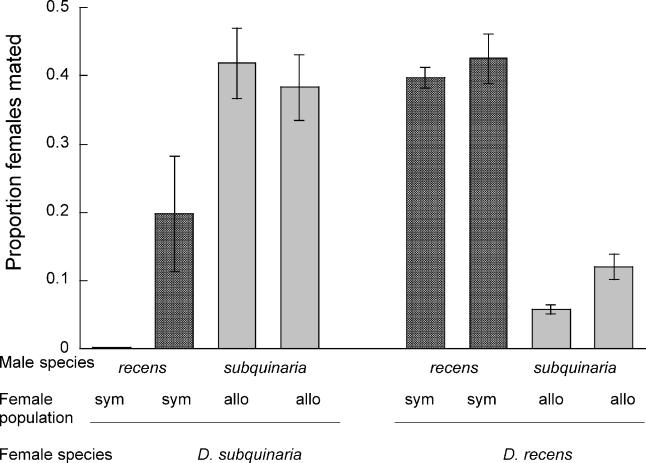
Proportion of Either Sympatric (sym) or Allopatric (allo) Females of D. recens and D. subquinaria That Mated with Either D. recens or D. subquinaria Males in the Mass Population Choice ExperimentsFor example, within trials, an average of 20 of the 100 allopatric females of D. subquinaria mated with D. recens males and 38 of them mated with D. subquinaria. Means ± standard error among three replicate trials.